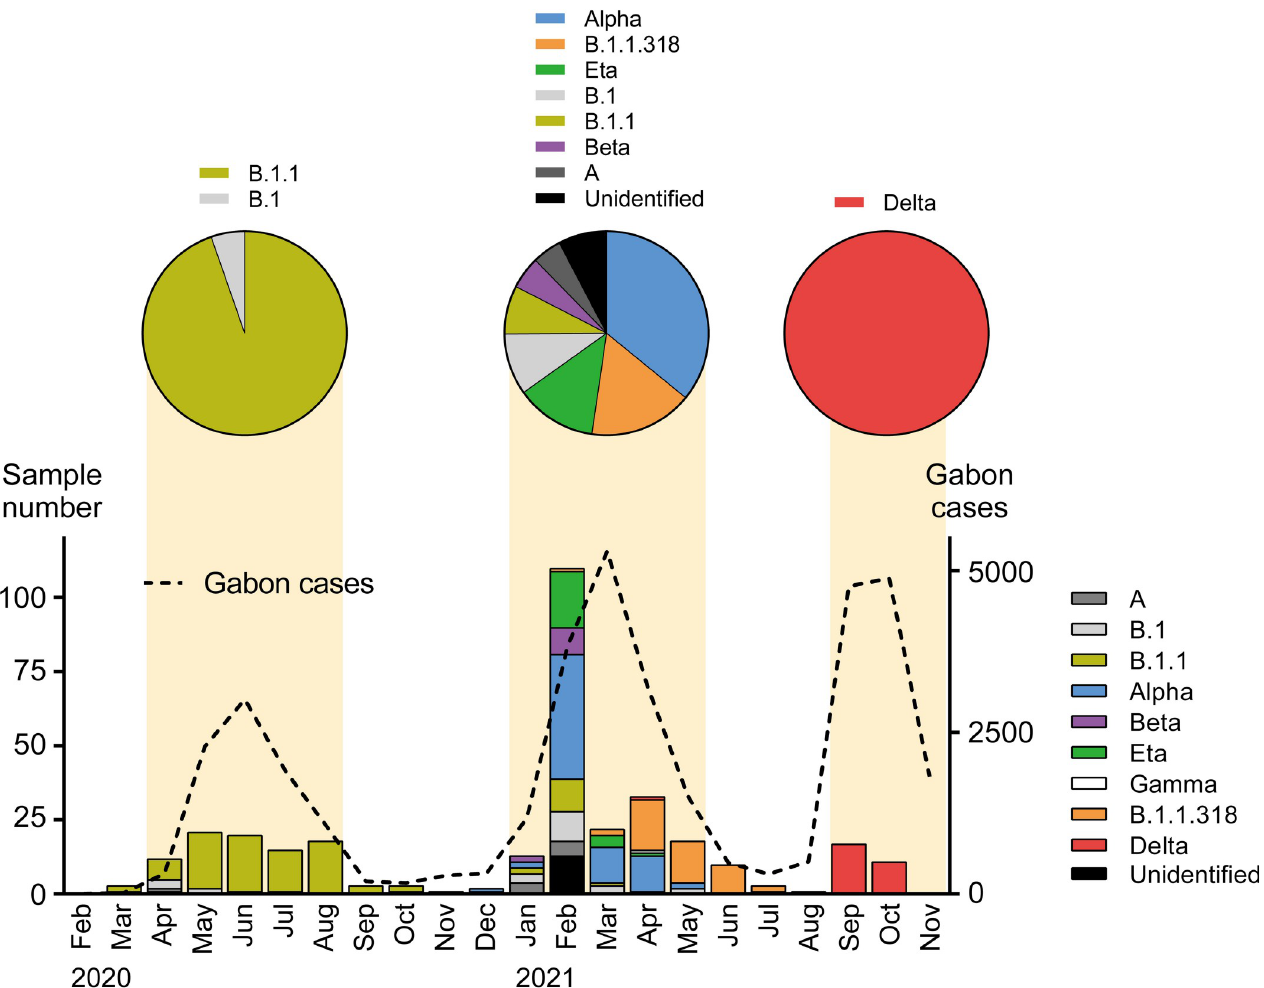
Fig 1. Number of collected samples and SARS-CoV-2 lineage determination during COVID-19 waves in Gabon. The number of samples collected every month is shown on the graph. Bar colors depict the lineages of SARS-CoV-2 detected in each sample. Monthly COVID-19 cases in Gabon are represented on the graph with a dotted line. The first, second, and third waves of COVID-19 are highlighted in orange, and the lineages of SARS-CoV-2 detected in samples collected during each COVID-19 wave are shown in the upper pie